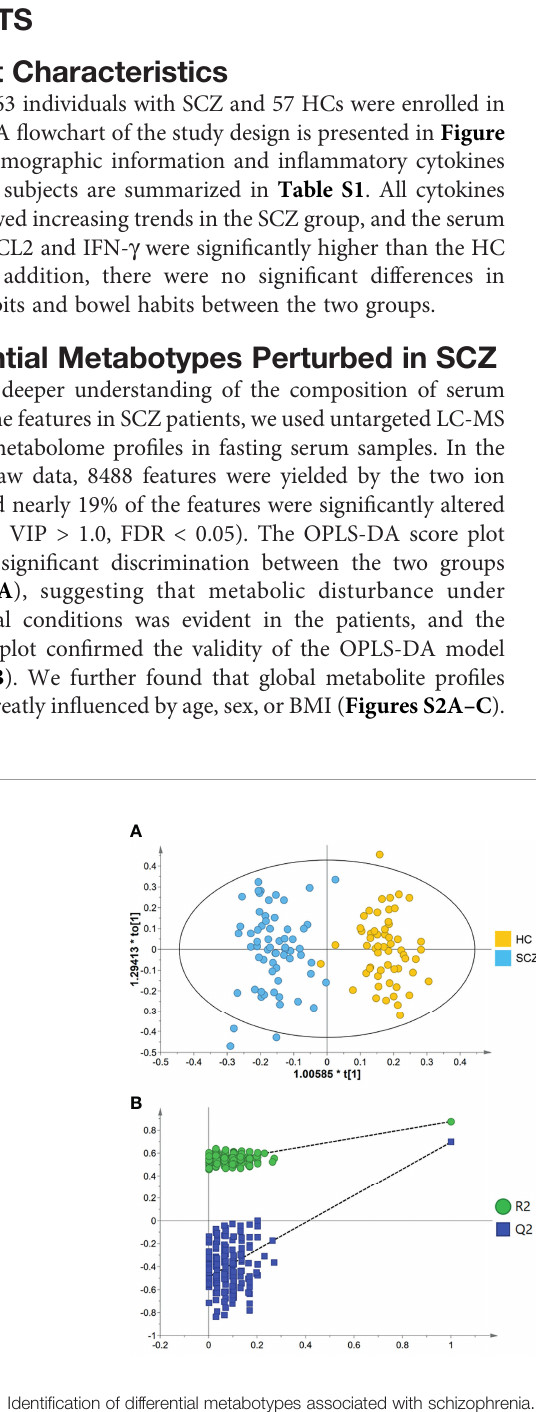
FIGURE 1 | Identi fi cation of differential metabotypes associated with schizophrenia. (A) The orthogonal partial least squares discriminant analysis (OPLS-DA) model was used to discriminate between 63 SCZ subjects (blue boxes) and 57 HCs (yellow diamonds). (B) Permutation test showing the original R2 and Q2 values (top right) as signi fi cantly higher than corresponding permuted values (bottom left), demonstrating the OPLS-DA model ’ s robustness. (C) Average relative intensities of the 18 co-abundance metabotypes (clusters) between the two groups. Red and green represented relatively high and low densities, respectively. The asterisk represented a signi fi cant negative correlation between the metabotype and the duration of illness ( P -value < 0.05).